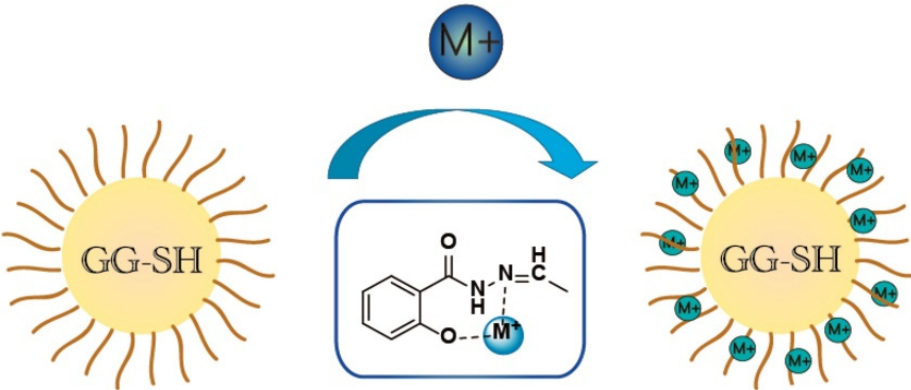
Figure 3. A scheme illustrated the complex process of heavy metal ions by the guar gum-based adsorbent